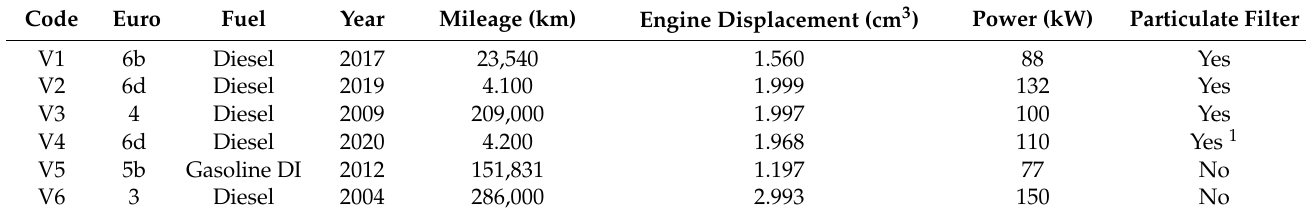
Table 3. Main characteristics of tested